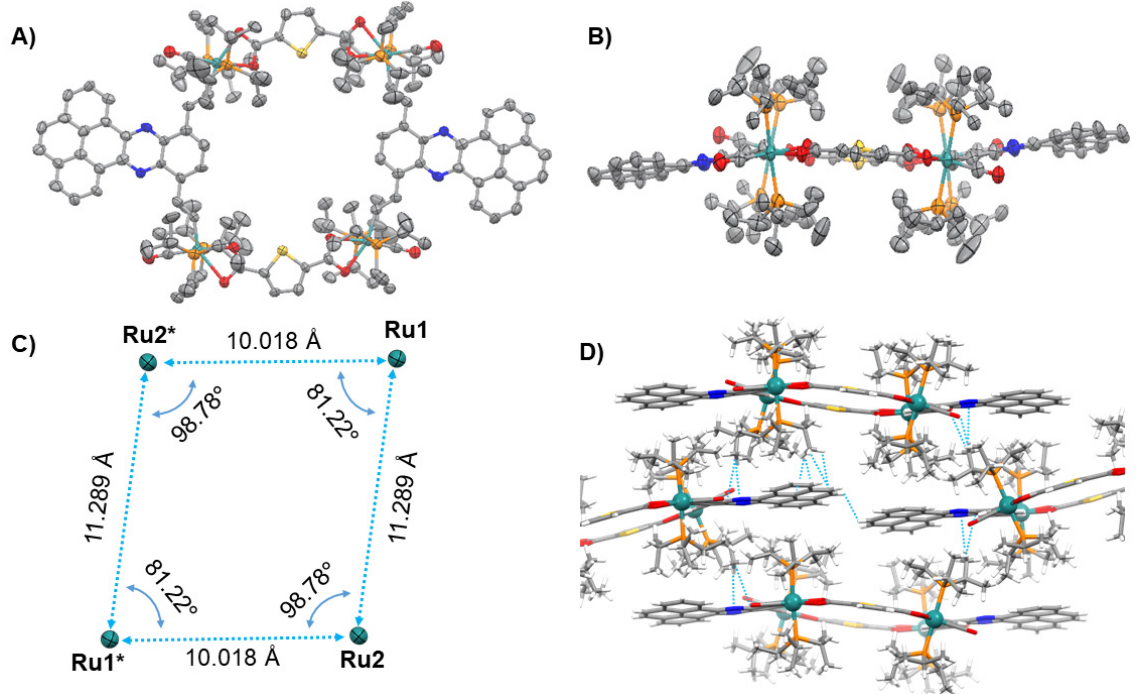
Figure 3. The structure of Ru 4 -5 in Ru 4 -5 ⋅ 4 CH 3 OH. For Figures ( A ) (top view) and ( B ) (side view), solvent molecules and hydrogen atoms were removed for clarity reasons. ( C ) Intracycle Ru ⋅⋅⋅ Ru distances and the inner angles of the tetraruthenium rhomboid. ( D ) Packing of individual molecules with intermolecular CH ⋅⋅⋅ π interactions, indicated as light blue dotted lines. The ellipsoids are displayed at a 50% probability level. Colour codes: grey, carbon; red, oxygen; orange, phosphorous; white, hydrogen; green, chlorine; dark turquoise, ruthenium.